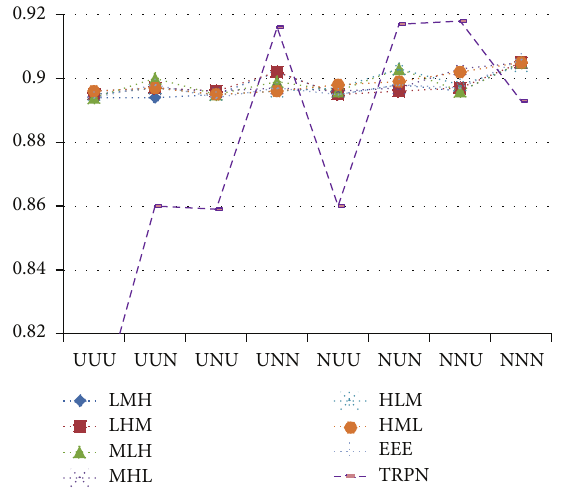
Figure 4: 𝑅 2 comparison of eight distributions with respect to several risk